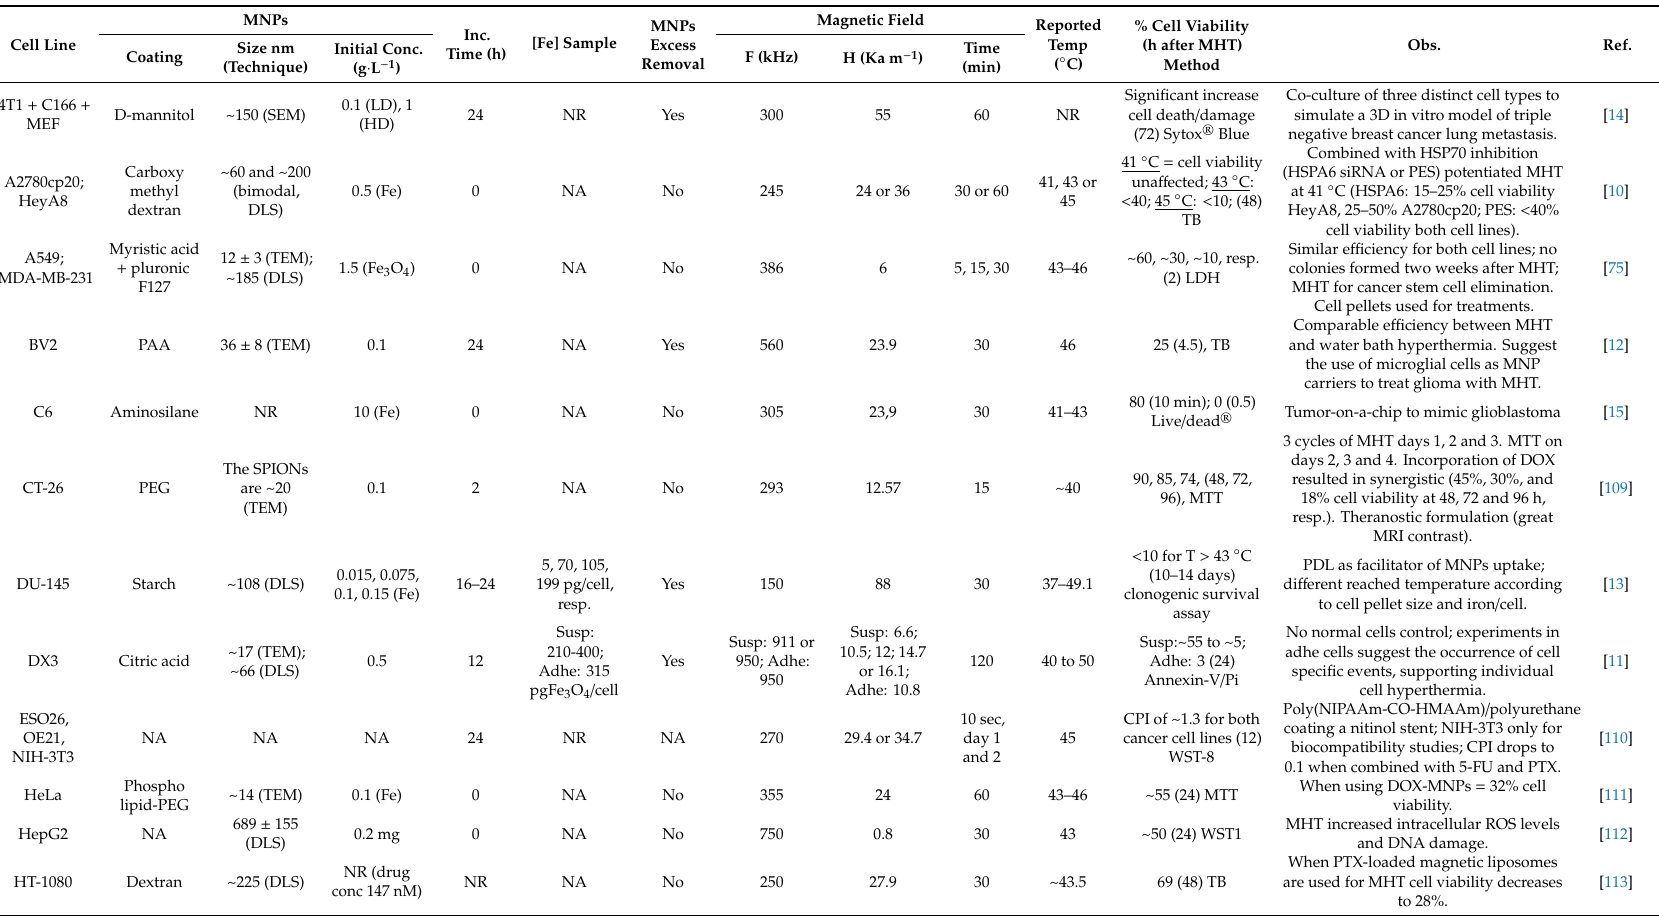
Table A1. Conditions used, and outcome observed, in in vitro studies using magnetic hyperthermia (MHT) alone or combined with other therapeutic regimens organized by the cell line in alphabetical order.